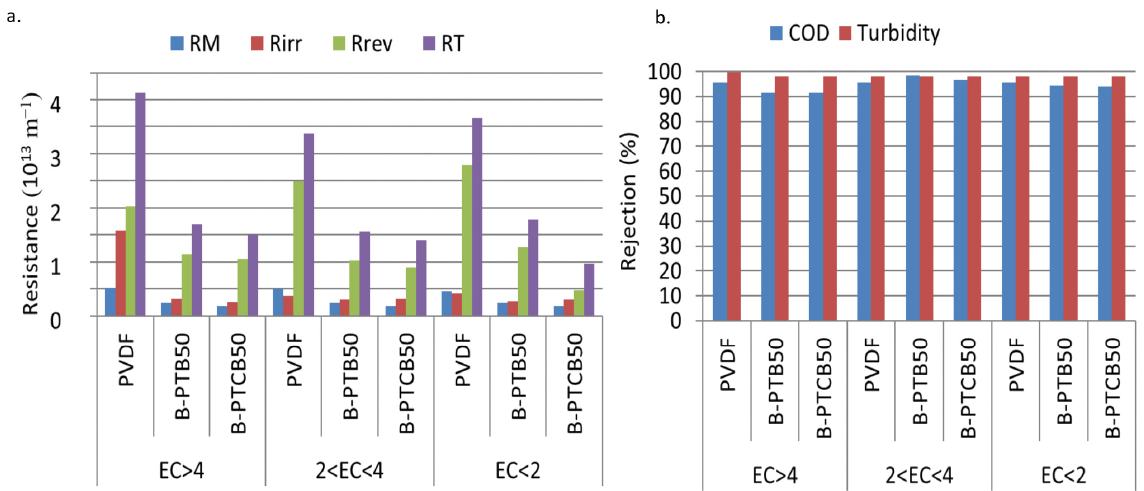
Figure 2. Effect of salinity on membrane fouling during synthetic dairy wastewater membrane filtration expressed by filtration resistances (where RM is membrane resistance, Rirr is irreversible resistance, Rrev is reversible resistance, and RT is total resistance) obtained from Equations (Section 3.6.2) ( a ) or COD and turbidity rejections ( b ).